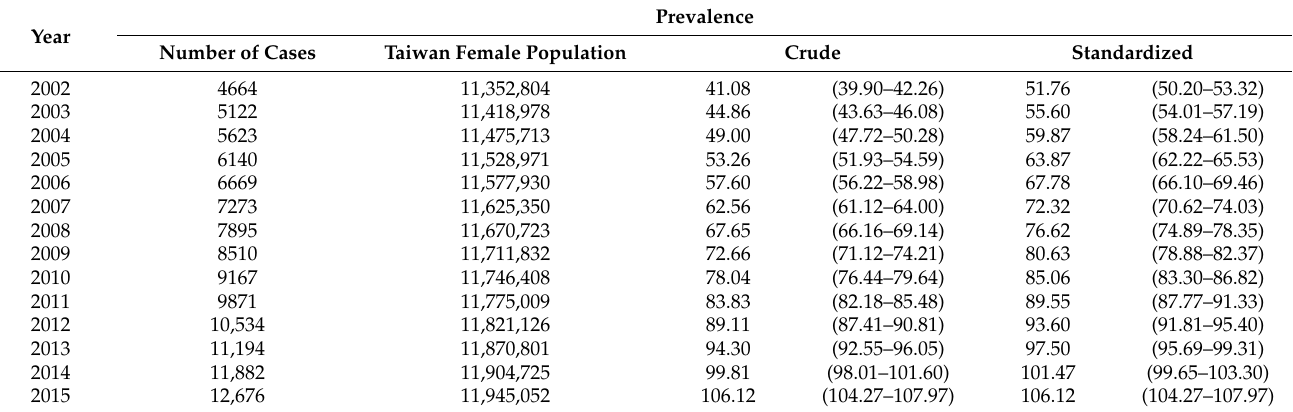
Table 2. Crude and age-standardized prevalence (per 100,000 people) of ovarian cancer in Taiwan from 2002 to